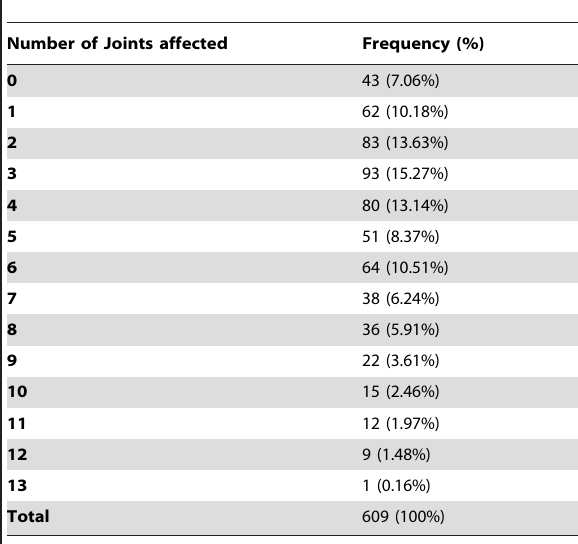
Table 2. Frequency of patients with different number of joints